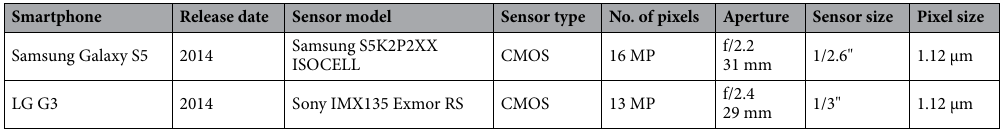
Table 5. Smartphone camera specifications used for data collecting.